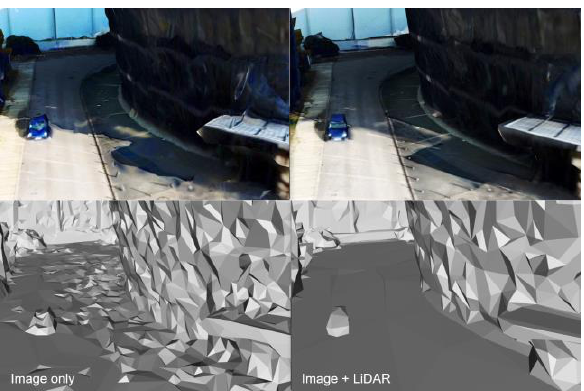
Figure 13: Comparison of 3D Mesh from image only (left) and image + LiDAR (right) approach. 3D mesh generated by Melown technologies from CityMapper-2 data, 5 cm